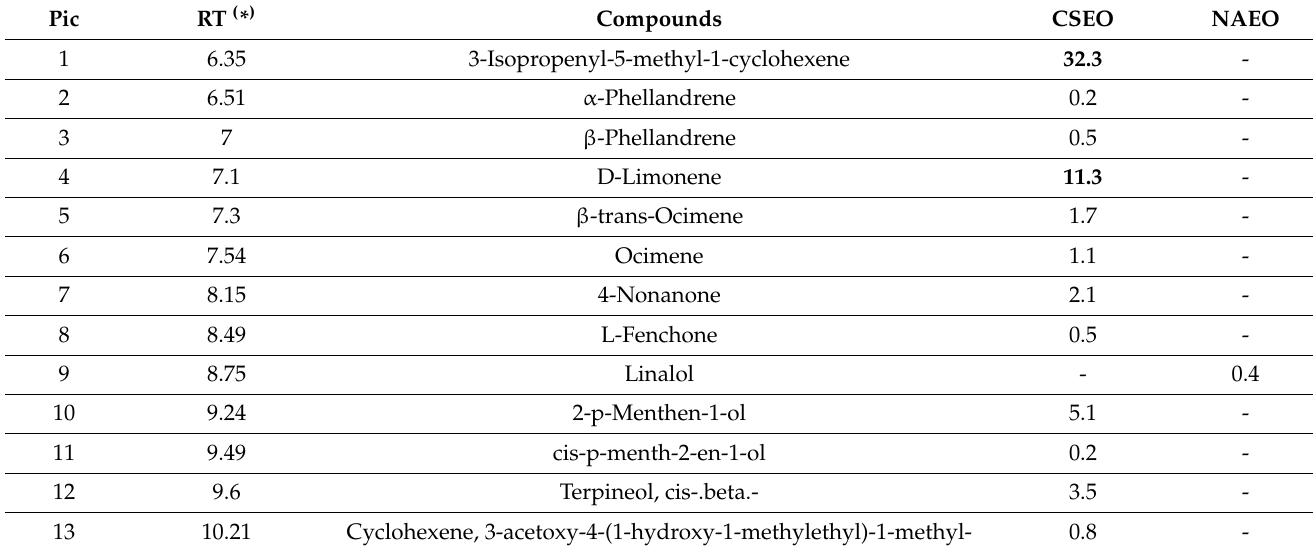
Table 4. Chemical compositions of CSEO and